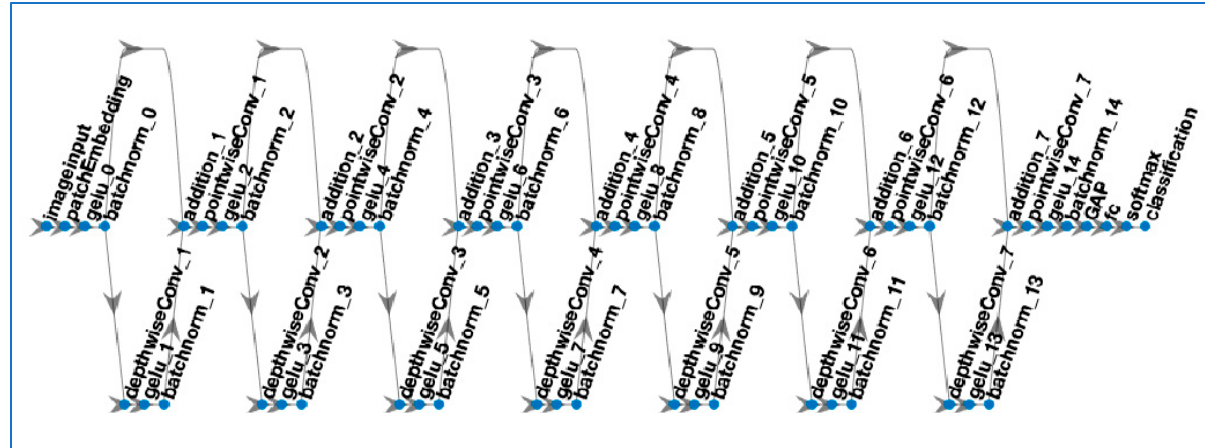
Figure 8. ConvMixer ‐ based neural network used in this study. The ConvMixer convolution layer parameters were set as filter number 32, filter size [5 5], stride [5 5], and dilation factor [1 1], and the ConvMixer first convolution layer weights obtained are shown in Figure 9 after the classification